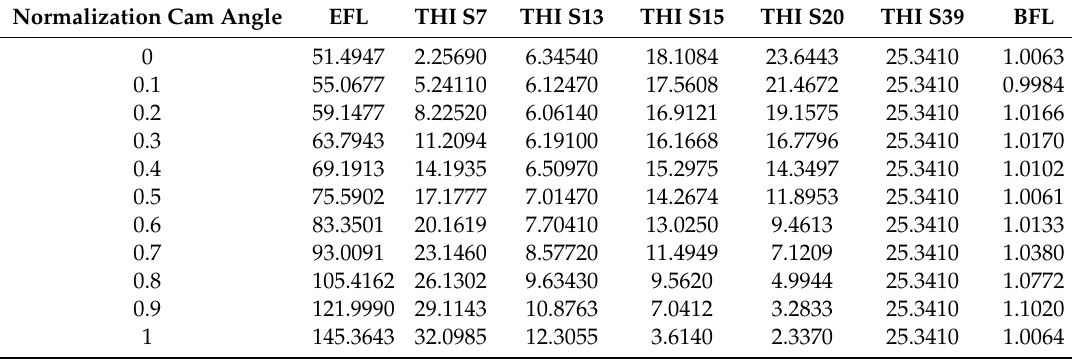
Table 10. Pad é approximation linearization of the second lens group for the optical system shown in Figure